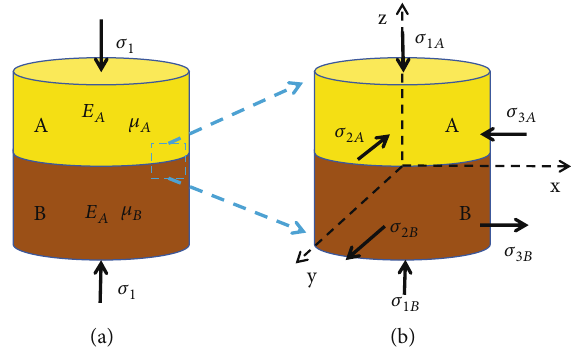
Figure 8: Stress state of layered rock